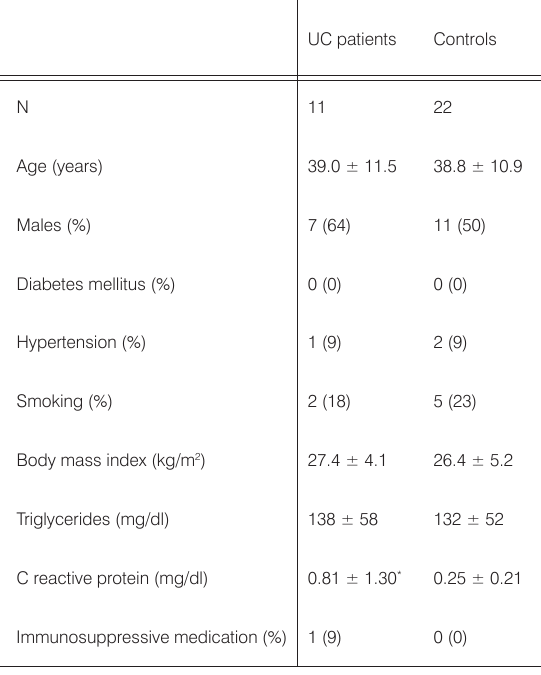
Table 1. Clinical data of patients with ulcerative colitis and that of controls